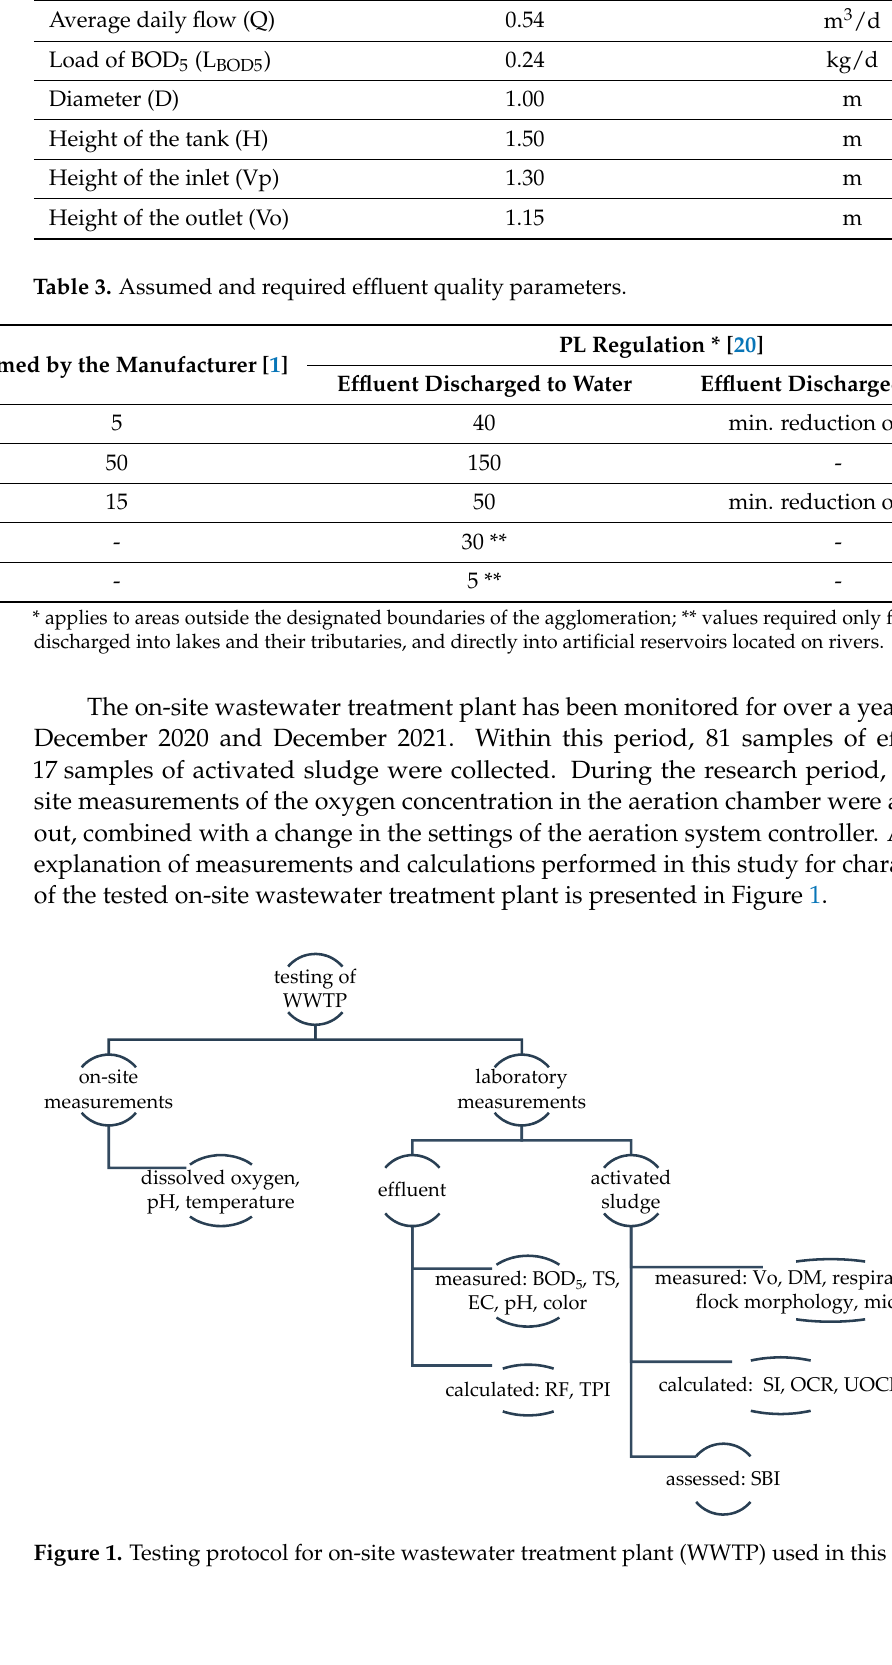
Figure 1. Testing protocol for on-site wastewater treatment plant (WWTP) used in this study .